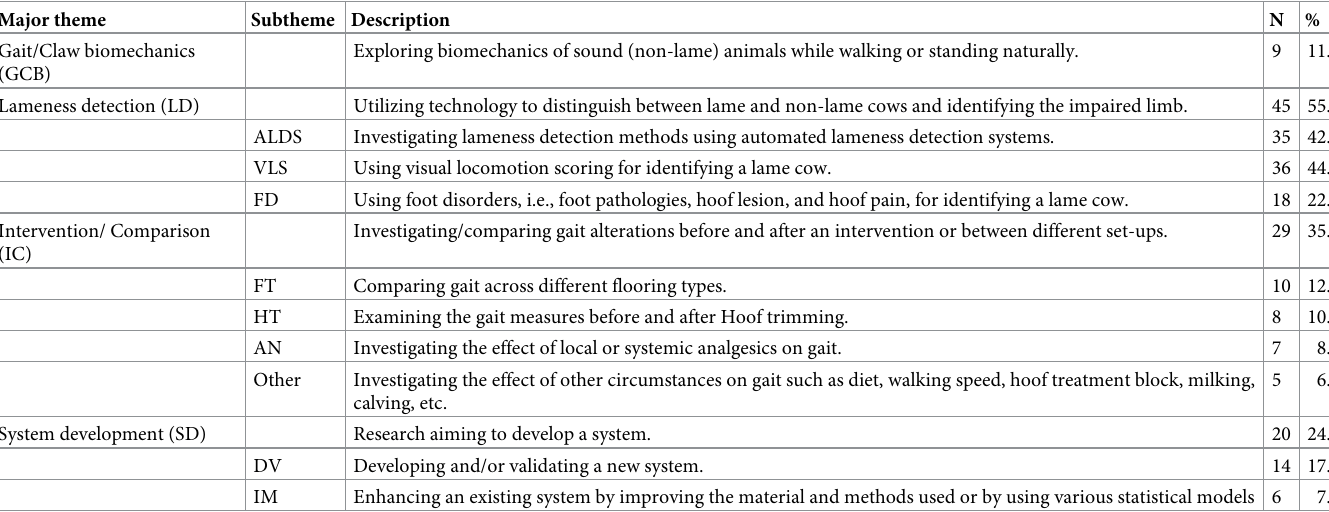
Table 2. Published trends in bovine biomechanical research, with findings derived from thematic analysis of stated research aims of the 82 included articles. Some papers were categorized under more than one main theme or subtheme (i.e., they aimed more than one